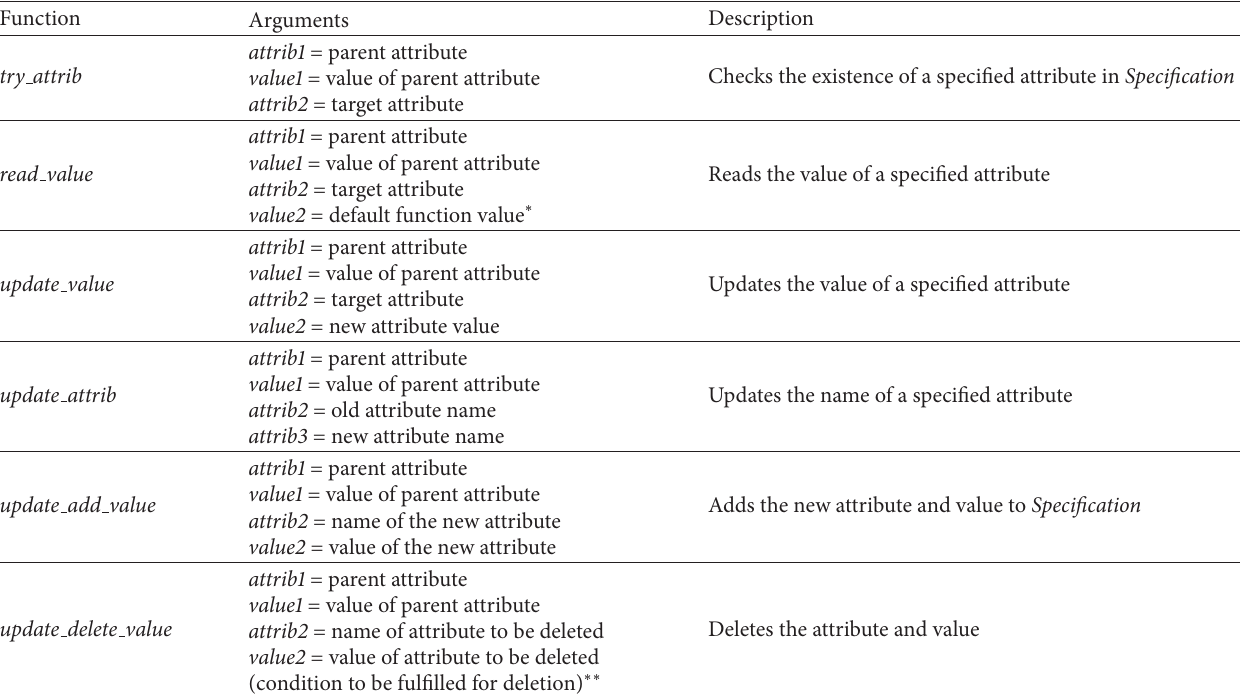
Table 1: Updating